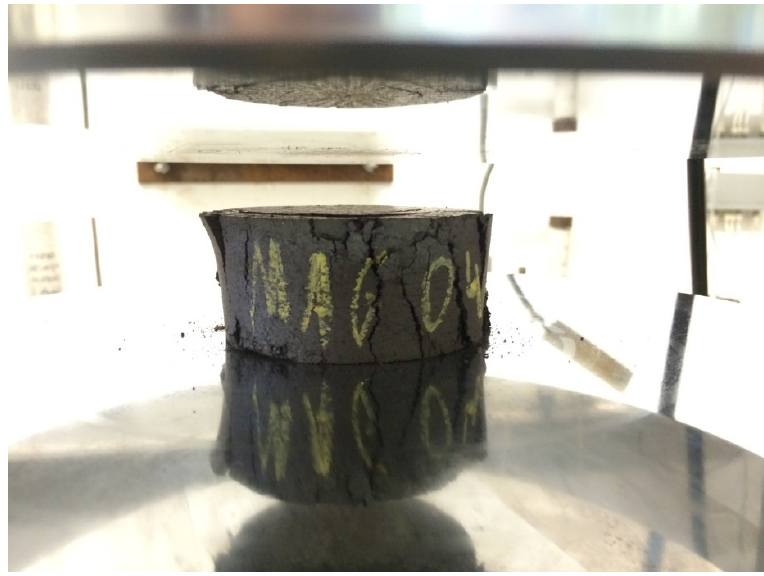
Figure 16. MA604 after the cold compression strength (CCS) testing procedure.